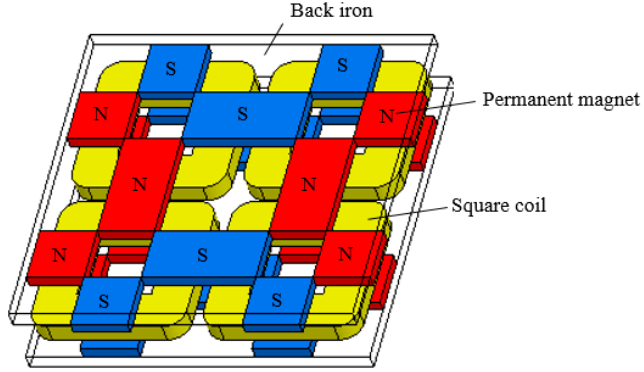
Figure 1. Basic configuration of the Lorentz-force-driven planar motor.